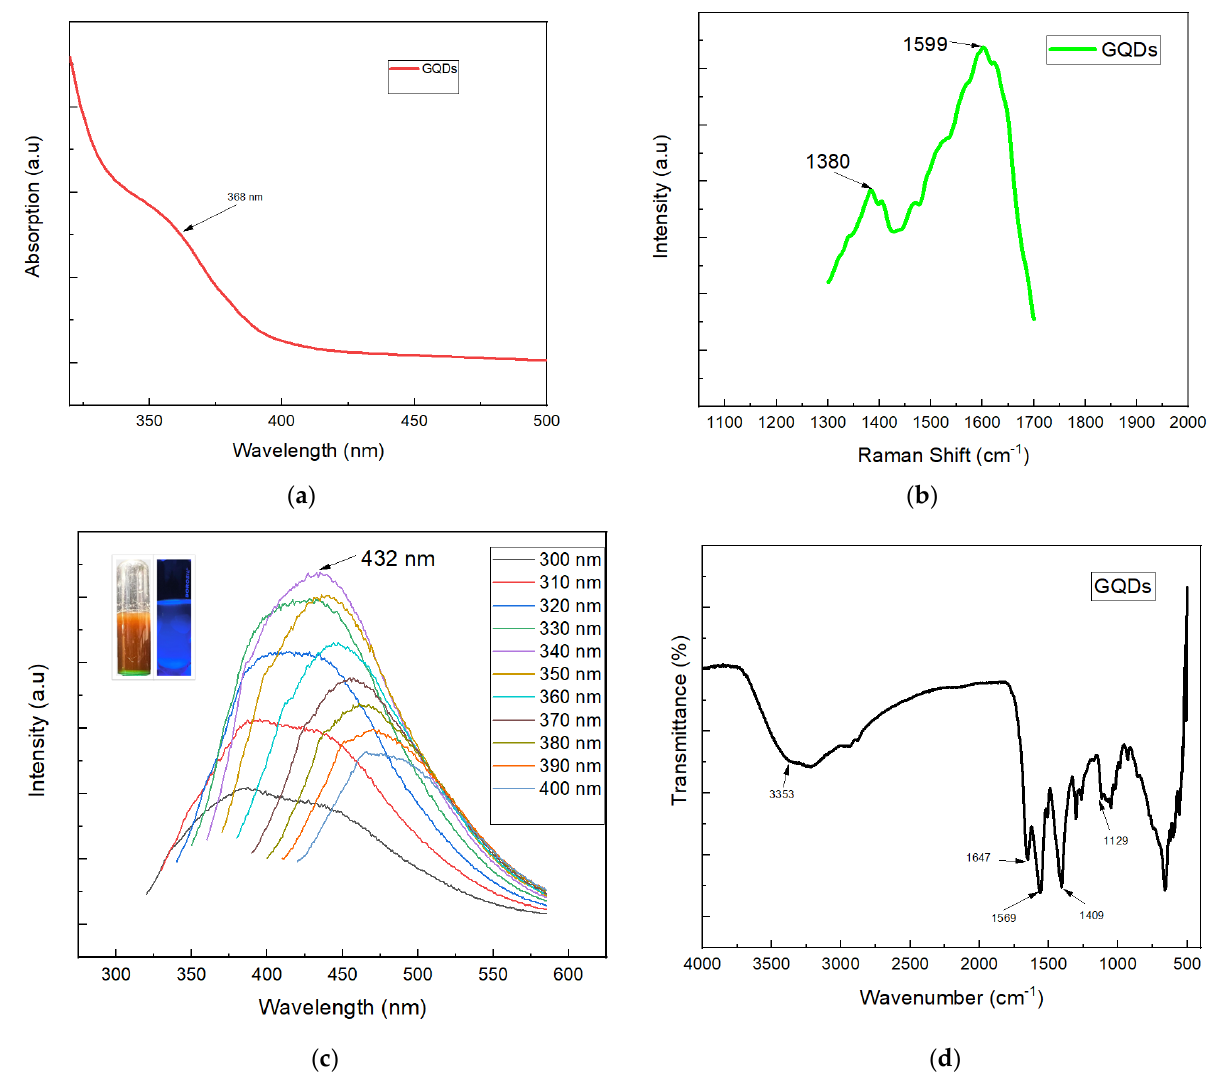
Figure 4. ( a ) UV−Vis Spectrum of GQDs ( b ) Raman spectrum of GQDs ( c ) photoluminescence spectra of the GQDs. Inset: photograph of the solution under daylight and UV light. ( d ) FTIR spectrum of GQDs.